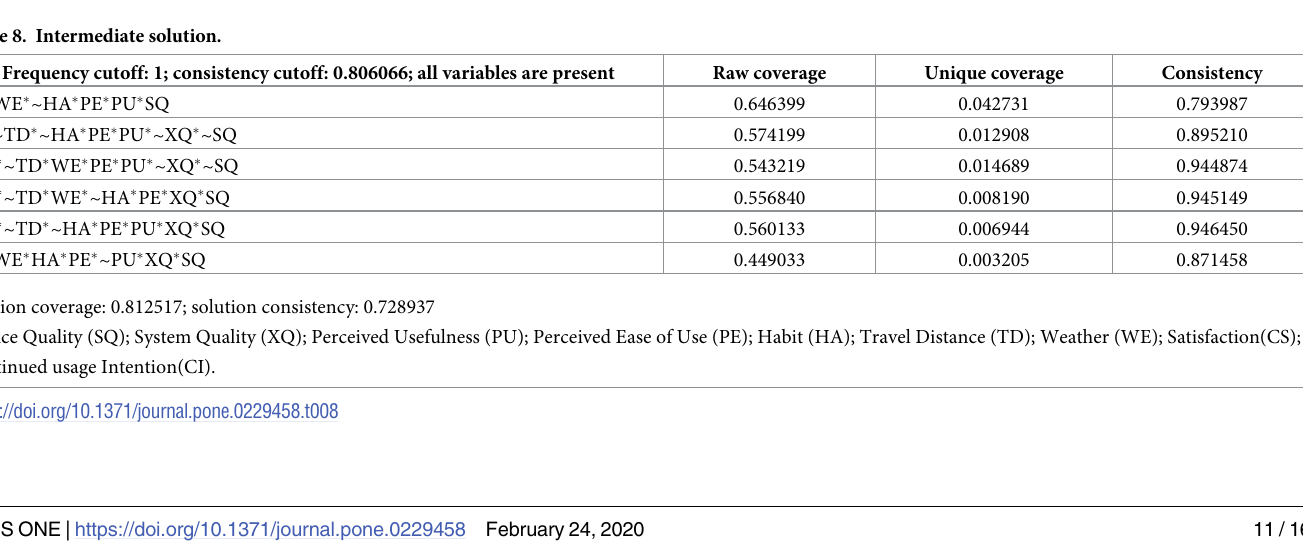
sufficiency conditions, we set the frequency cutoff in the truth table at 1 and the consistency cutoff at 0.806066 (all variables were present for the occurrence of discontinued usage intention). Six combinations of causal conditions in the intermediate solution could promote discontinued usage intention. The most important condition combinations were satisfaction × weather × ~ habit × perceived ease of use × perceived usefulness × service quality (raw coverage: 0.646399; consistency: 0.793987) because they present the highest raw coverage values.